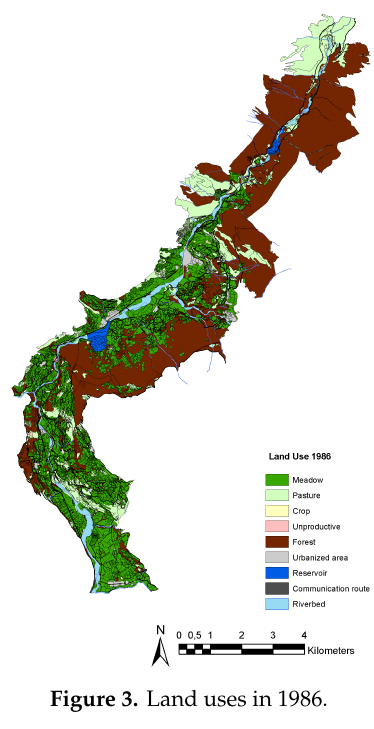
Figure 3. Land uses in 1986.